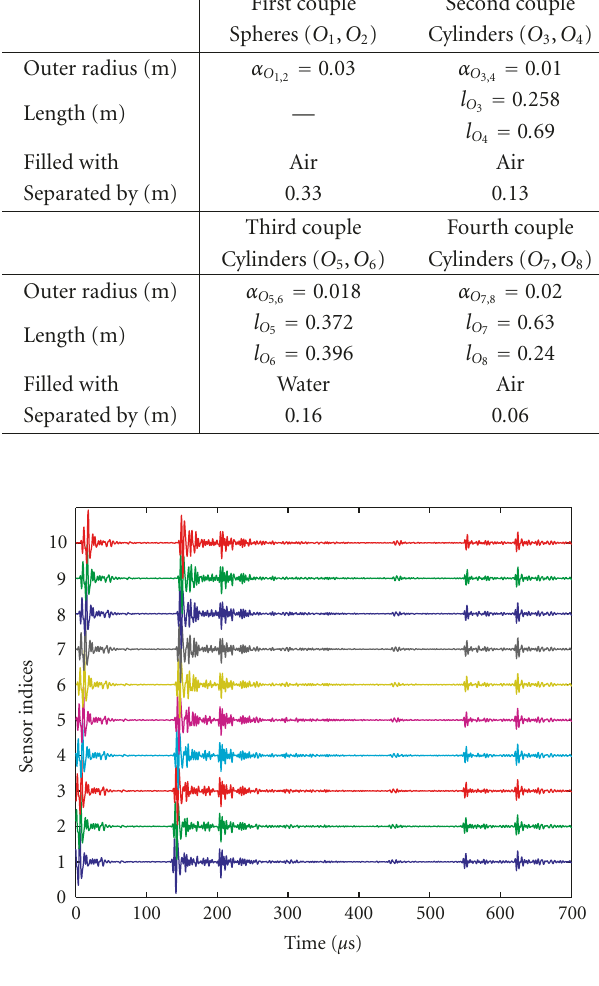
Figure 5: Observed sensor output signals.